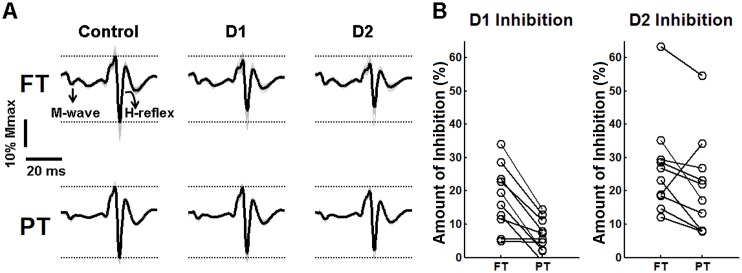
Effects of D1 and D2 inhibitions on soleus H-reflex amplitude during plantarflexion force and position tasks.(A) Representative data for one subject, showing raw H-reflexes (thin lines) obtained during FT (upper traces) and PT (lower traces) trials. M-waves and H-reflexes are shown, as indicated by the arrows in the upper signal. The thick lines indicate the average M-waves and H-reflexes. Three experimental conditions are depicted: control condition (left traces), D1 inhibition (middle traces), and D2 inhibition (right traces). (B) Individual values of the amount of inhibition computed for D1 and D2 conditions during force and positions tasks (FT and PT).